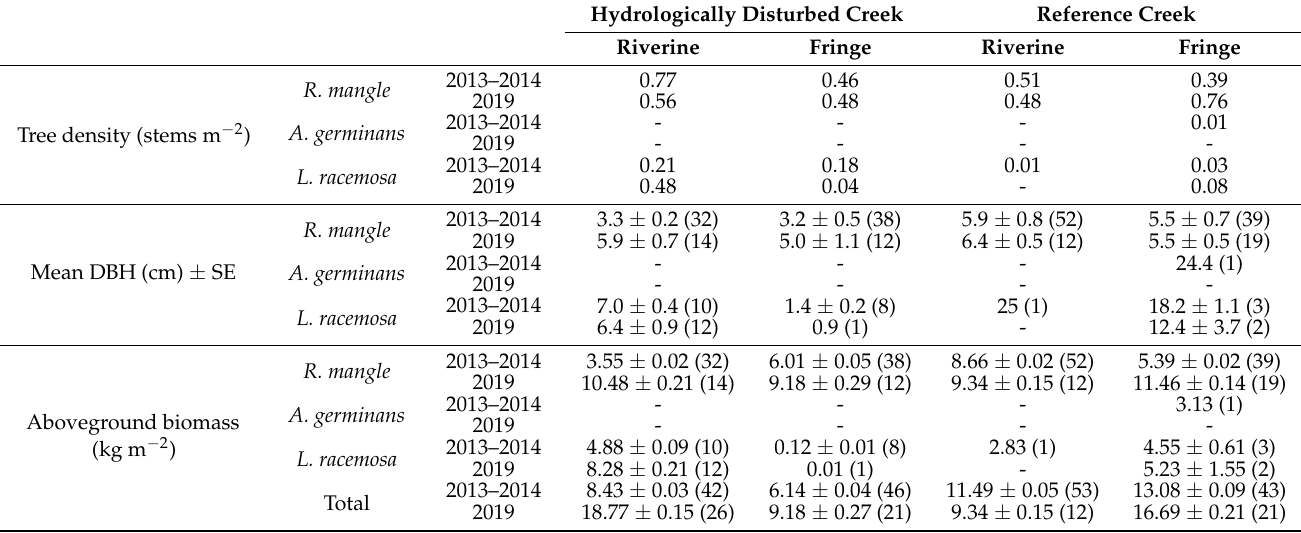
Table 1. Mangrove stem density and diameter at breast height (DBH) and estimated aboveground biomass of mangrove communities from 2013 to 2014 [10] and 2019 (this study) in hydrologically disturbed and reference creeks in Naples Bay, Florida ± standard error (number of samples).